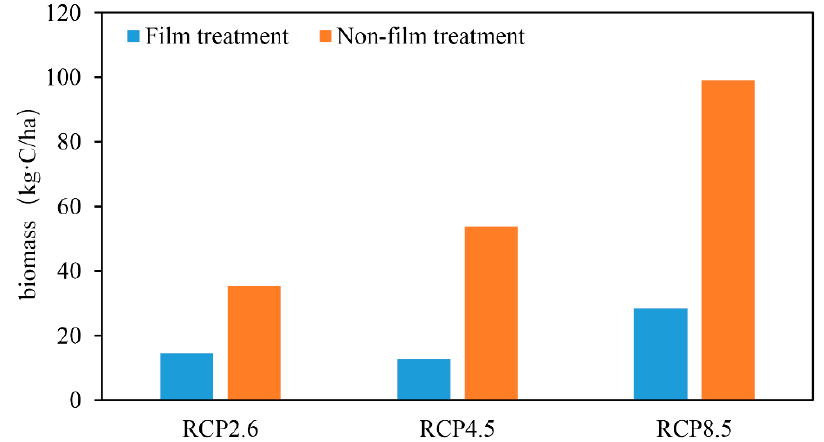
Figure 8. Changes in maize biomass under three emission pathways for average situations of the three climate scenarios.